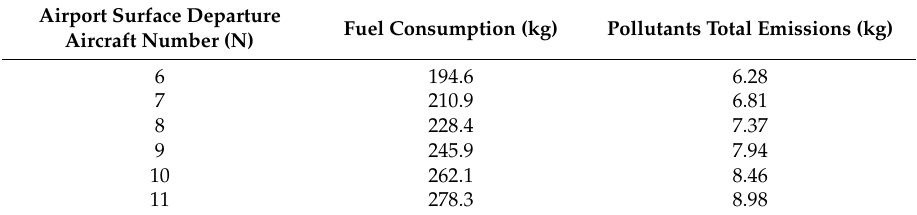
Table 5. The total fuel consumption and total pollutant emissions of departing aircraft under different departure control strategies.